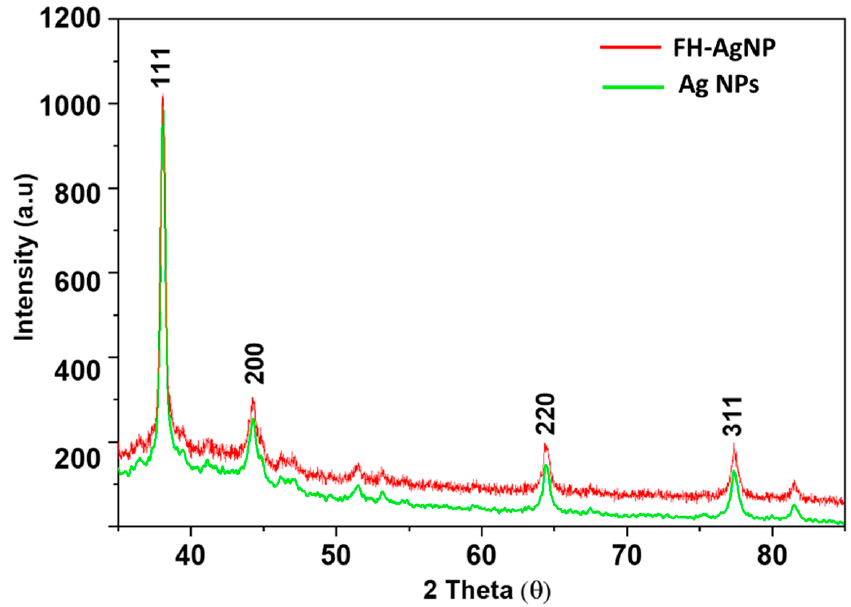
Figure 3. XRD analysis of AgNPs and FH-AgNPs.